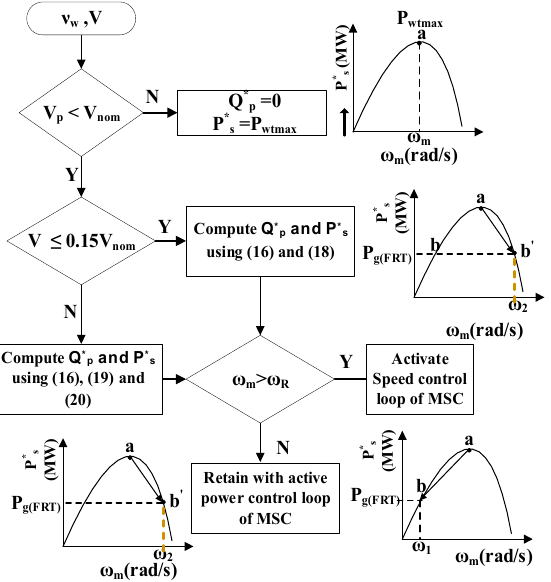
Figure 5. Proposed power reference scheme under symmetrical sag.